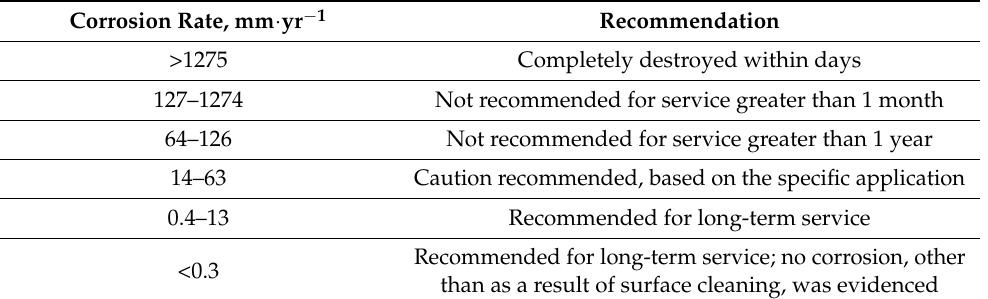
Table 3. Guide for corrosion rates used in the industry